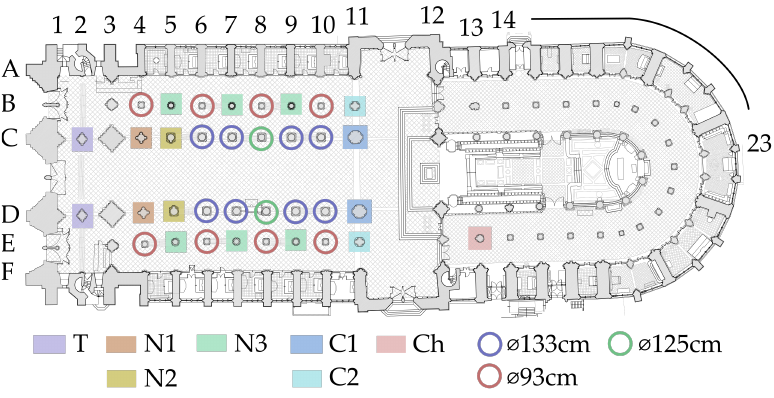
Figure 2. Floor plan with piers, columns, and responds locations. The shafts of identical cross-sections from the selected groups under study are highlighted with a common color. The columns of the nave with circular shafts are indicated with a circle.